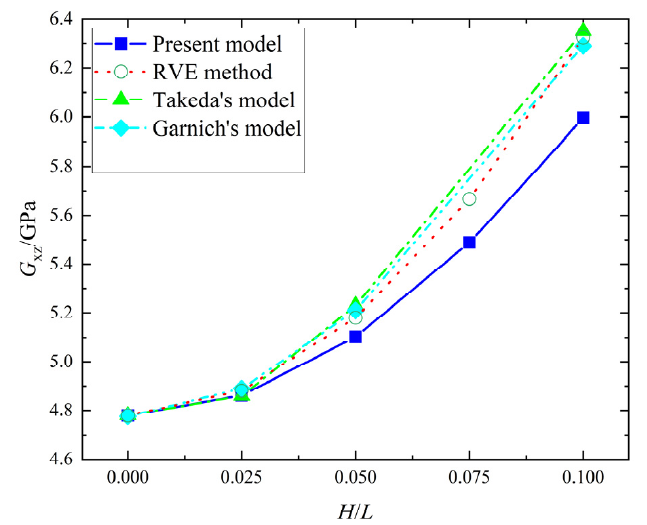
Figure 6. G xz in the four models . Table 3. Effective elastic properties of a unidirectional laminate with wrinkles in different models.